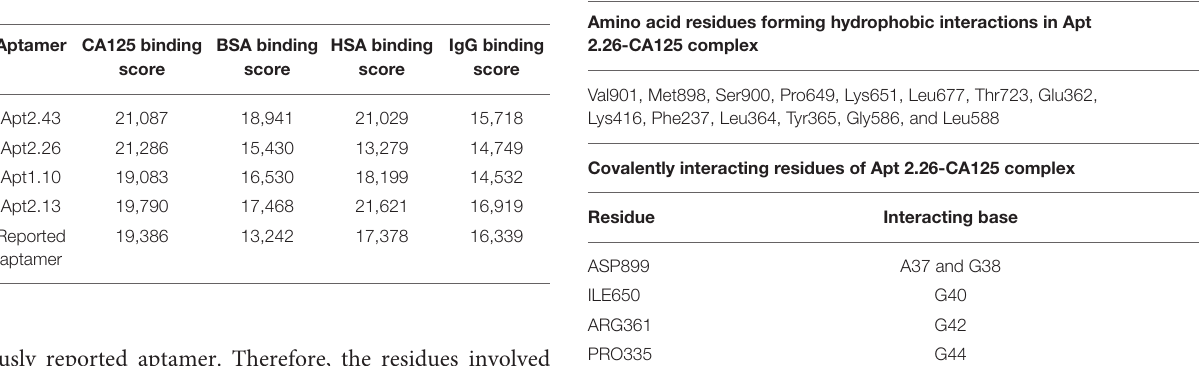
TABLE 3 | Binding pockets and various interactions in Apt 2.26-CA125